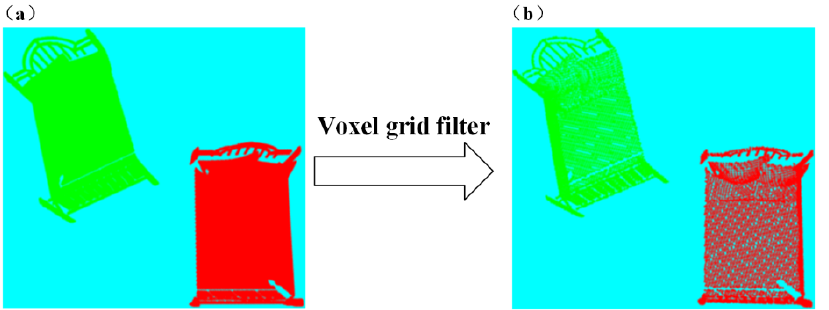
Figure 2. Down sampling of the “Bed”; (a) the point cloud to be registered, (b) the down sampling result.